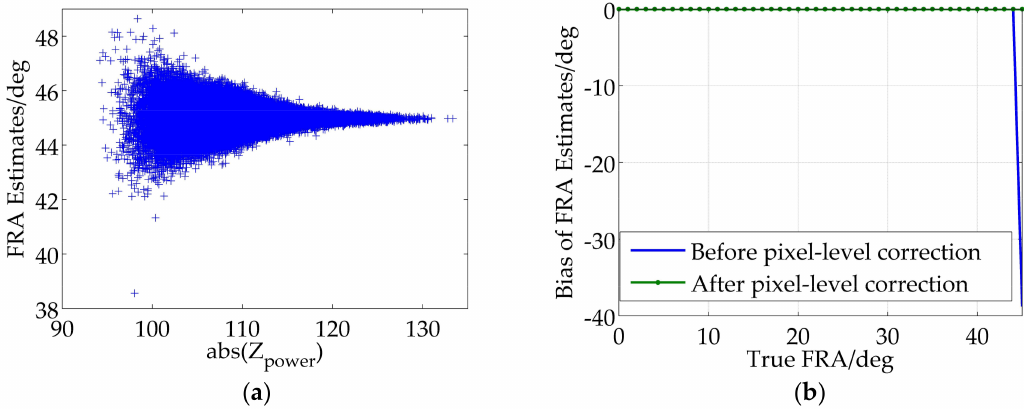
Figure 8. ( a ) FRA estimates after pixel-level correction as the true FRA is set to 45 ◦ ; ( b ) Bias of FRA estimates as a function of true FRA after pixel-level correction.